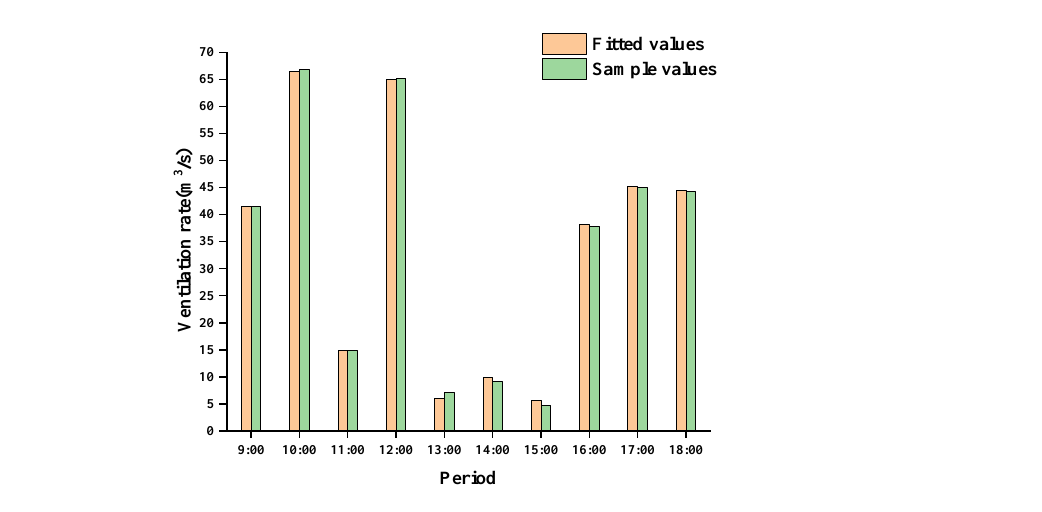
Figure 20. Comparison of calculated and fitted results before the correction of the ventilation rate in the plain area.